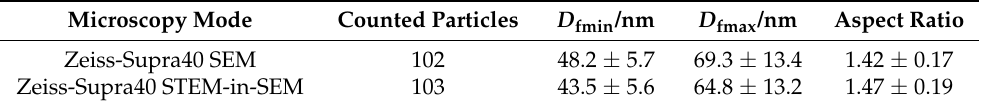
Table 3. Result of the image analysis of the same field-of-view with TiO 2 NPs by Zeiss-Supra40 SEM with InLens secondary electron detection and by Zeiss-Supra 40 STEM-in-SEM, both at 3 kV. Microscopy Mode